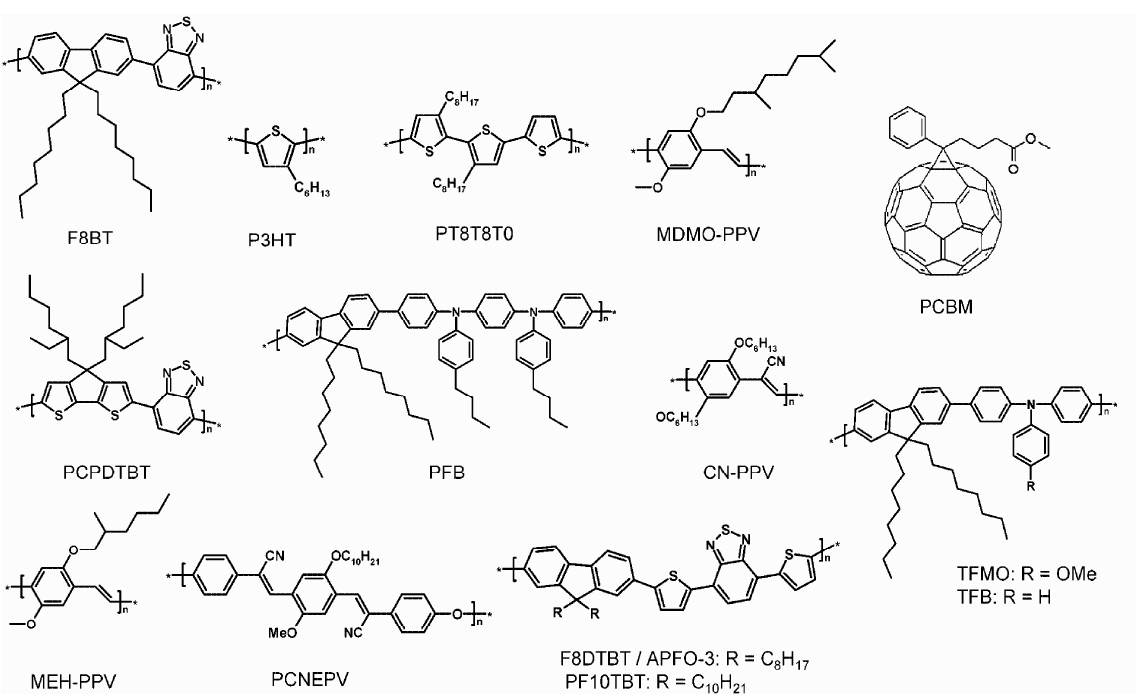
Figure 11. Some of the most used organic semiconductor materials in OSCs. (Reprinted with permission from Reference [110]. Copyright (2010) by American Chemical